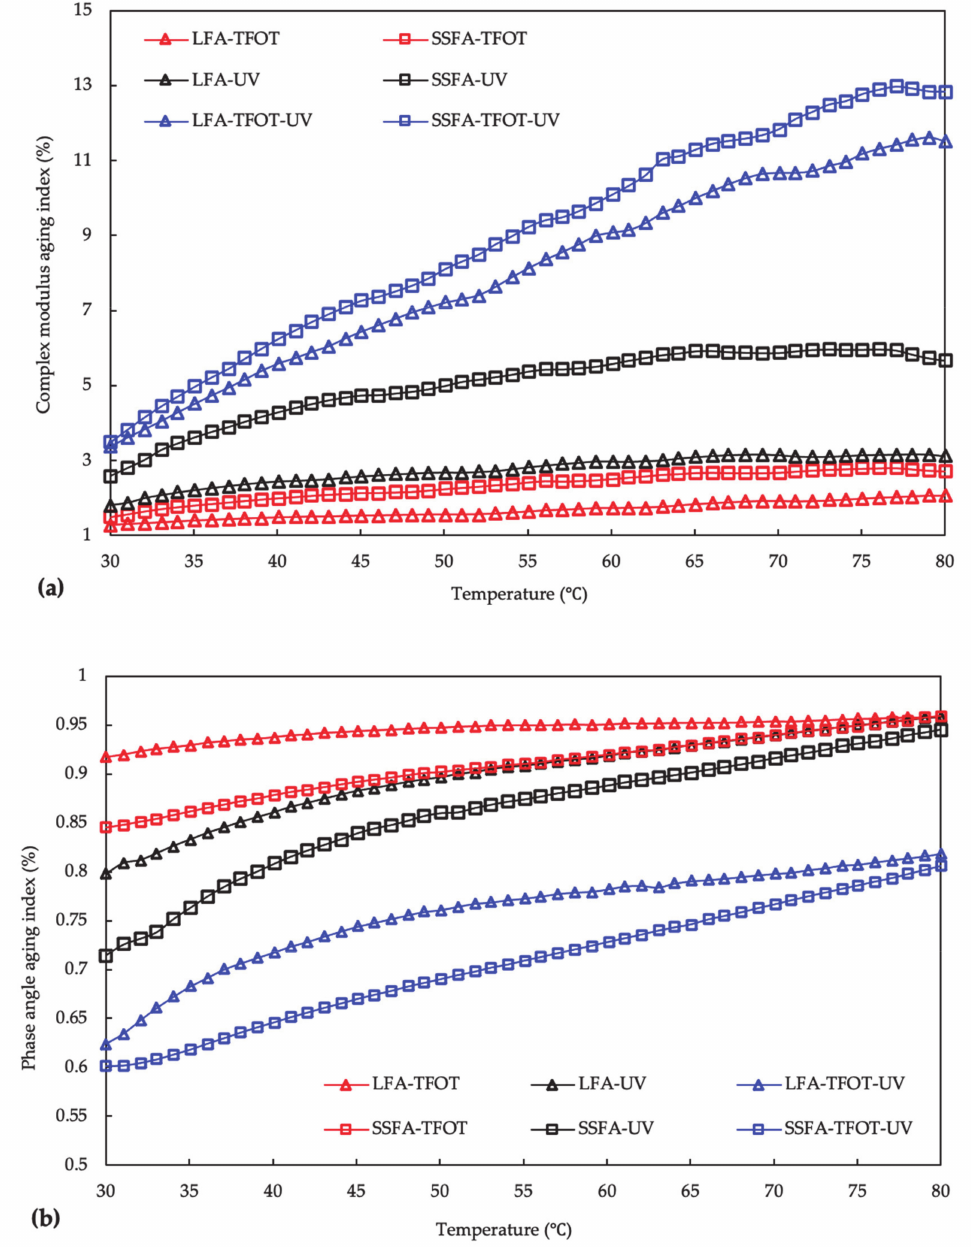
Figure 10. The changes of rheological properties of SSFA and LFA before and after TFOT/UV/TFOT+UV aging: ( a ) complex modulus aging index; ( b ) phase angle aging